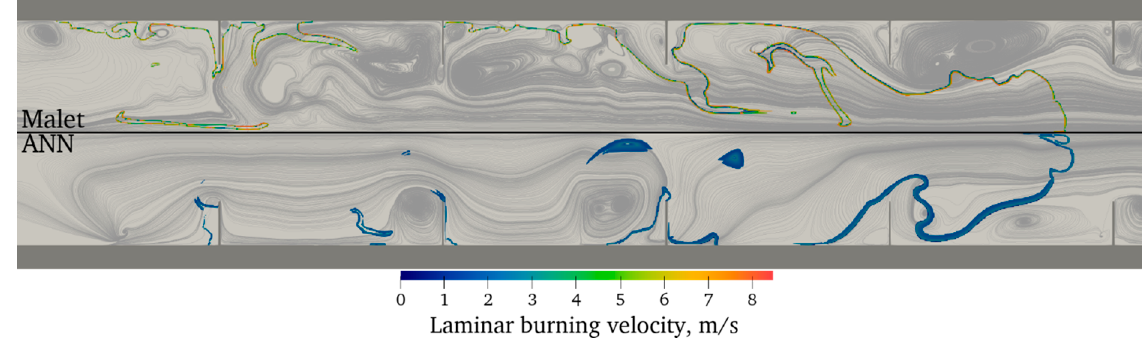
Figure 11. Simulated LBV distribution in ENACCEF2 at selected moments.